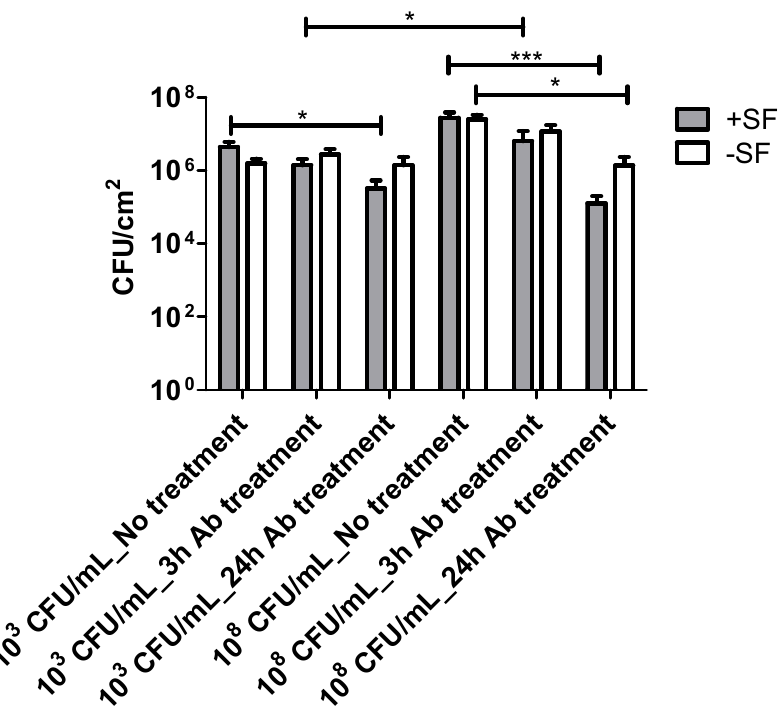
Figure 8. Confocal images of aggregated ( A , B ) and single cells ( C , D ) biofilms for 10 3 CFU/mL after 24 h antibiotic treatment. Panel B and D are zoomed images. Biofilms stained with DAPI for eDNA, WGA stain for PNAG or SF-derived HA, and PI for staining dead cells. Merged images denote the combination of DAPI, WGA, GFP, and PI images. GFP-PI is combination of GFP and PI images.